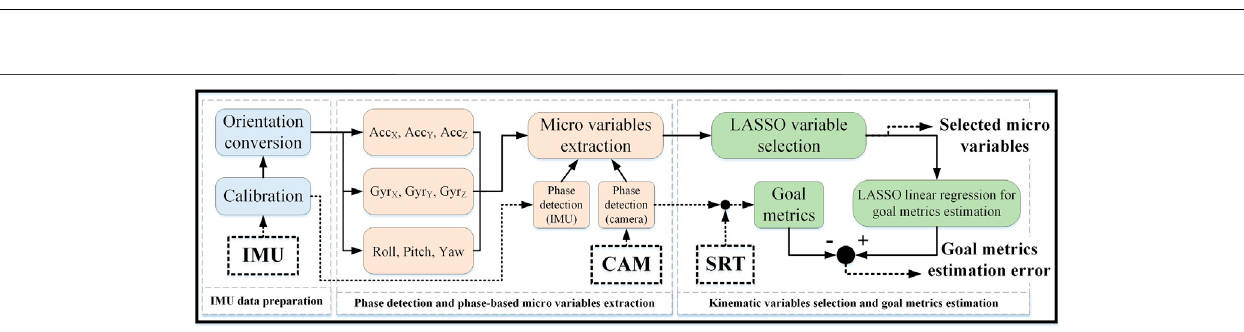
Frontiers in Bioengineering and Biotechnology |